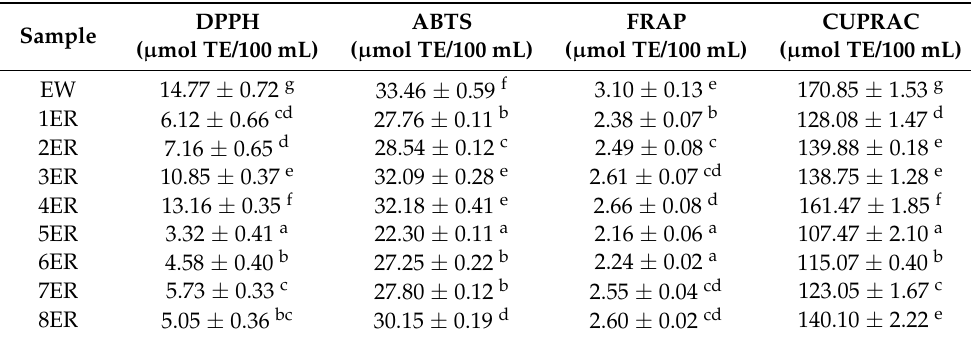
Table 8. Antioxidant activity determined by DPPH, ABTS, FRAP, and CUPRAC in initial ecological Cabernet Sauvignon wine and retentates obtained by reverse osmosis at 2.5, 3.5, 4.5, and 5.5 MPa with cooling and without